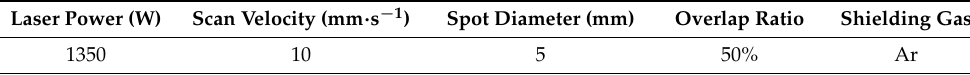
Table 1. Processing parameters of the laser cladding